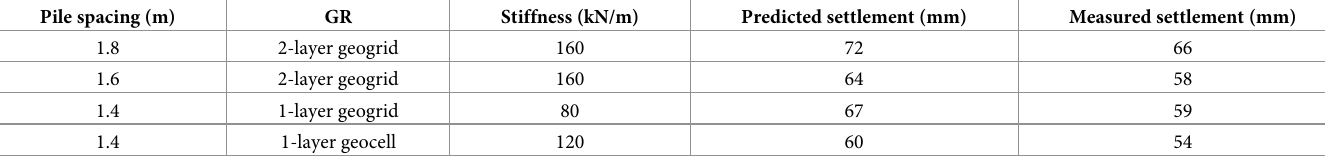
Table 8. Comparing the predicted embankment settlements with the measured data. Pile spacing (m)